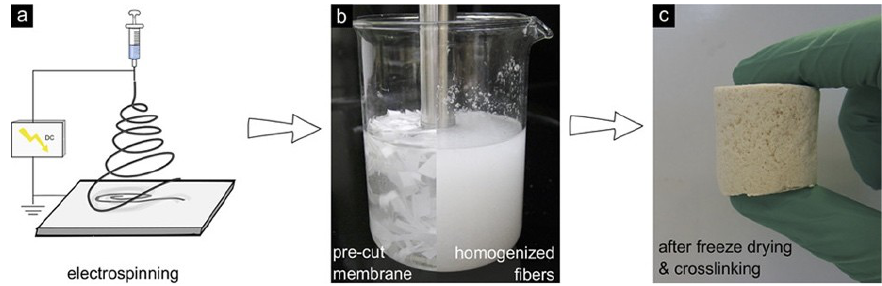
Figure 7. The processing schematic of aerogel fabrication via the electrospinning of nanofiber mats. Reprinted from [102] with permission, copyright American Chemical Society, 2018.